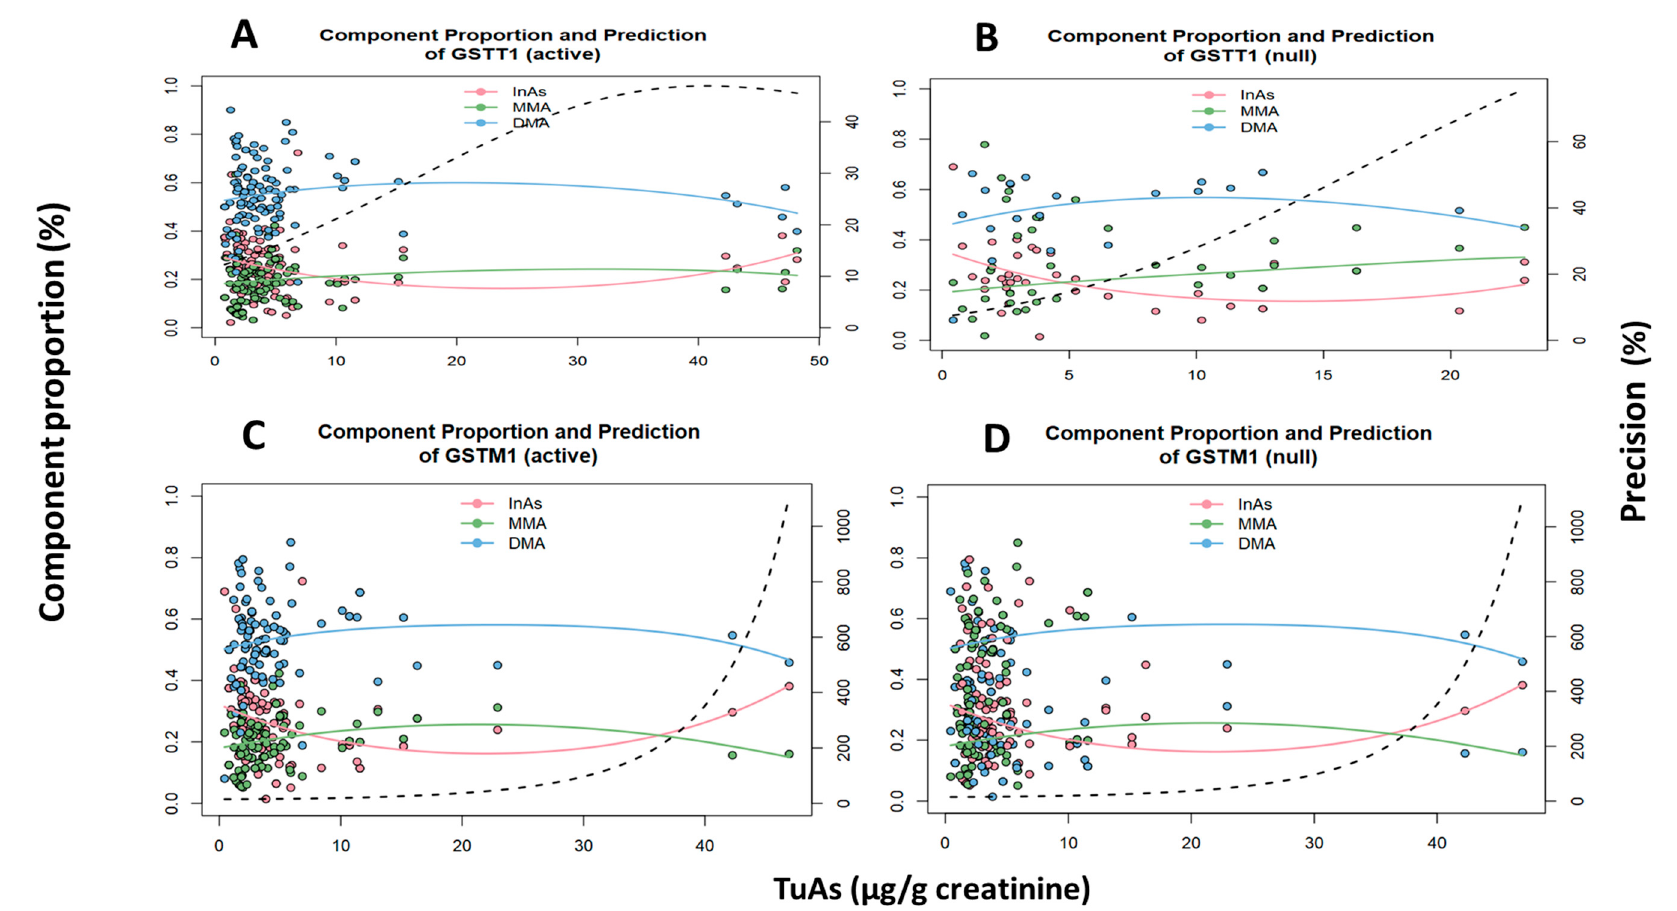
Figure 3. Multivariate Dirichlet regression on the relationship among the urinary arsenic metabolites and urinary As concentration by genotype adjusted. ( A ) Active GSTT1 : InAs ( p = 0.70), MMA ( p = 0.03), DMA ( p = 0.05). ( B ) Null GSTT1 : InAs ( p = 0.71), MMA ( p = 0.07), DMA ( p = 0.08) ( C ) Active GSTM1 : InAs ( p = 0.32), MMA ( p = 0.38), DMA ( p = 0.53) ( D ) Null GSTM1 : InAs ( p = 0.06), MMA ( p < 0.01), DMA ( p < 0.01).